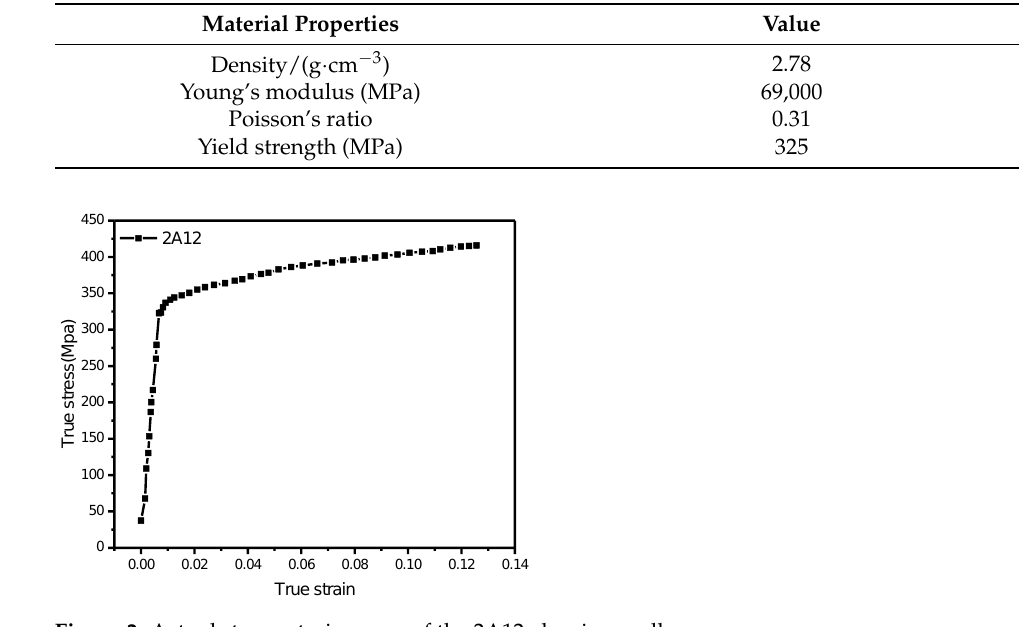
Figure 2. Actual stress – strain curve of the 2A12 aluminum alloy.